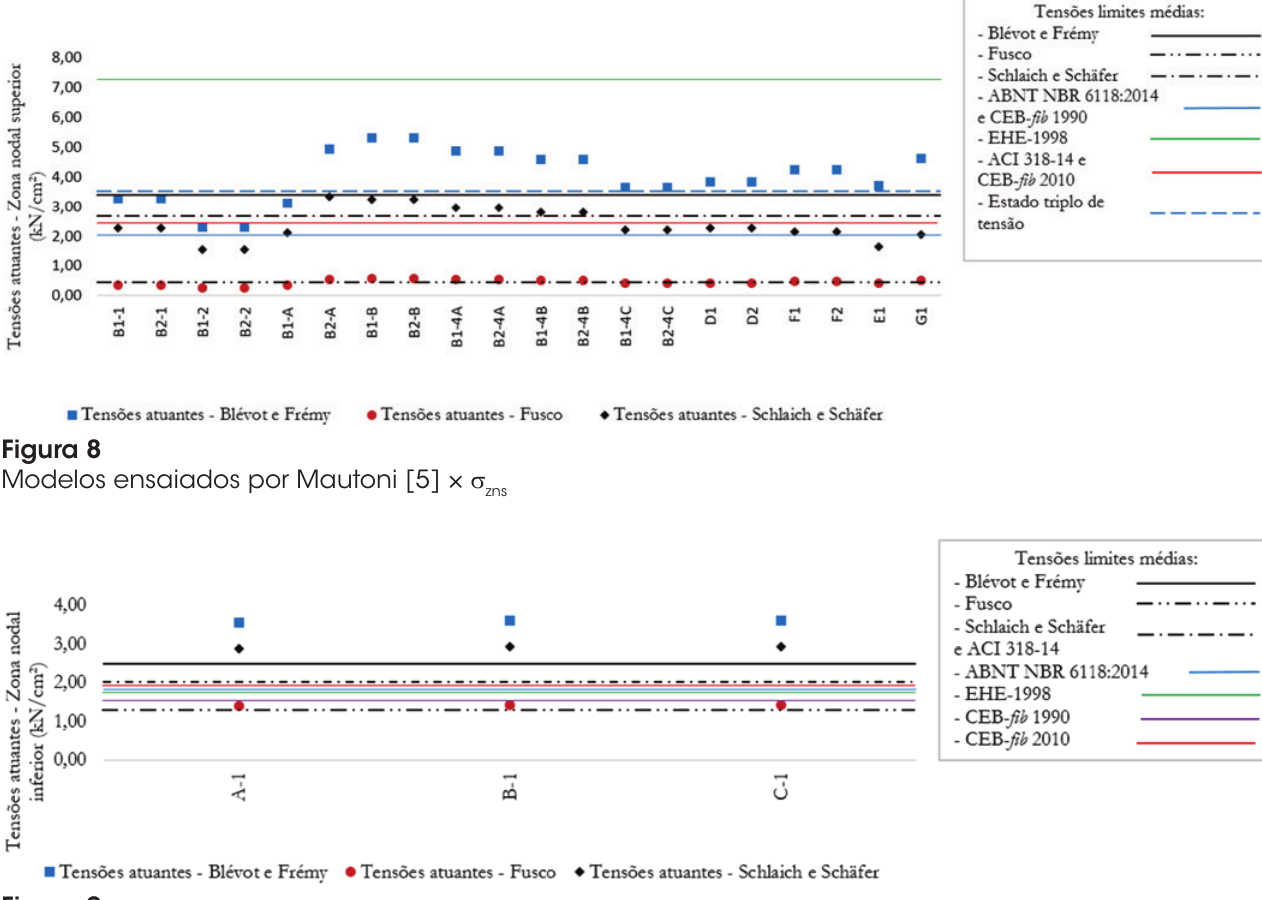
Modelos ensaiados por Fusco [6] × σ